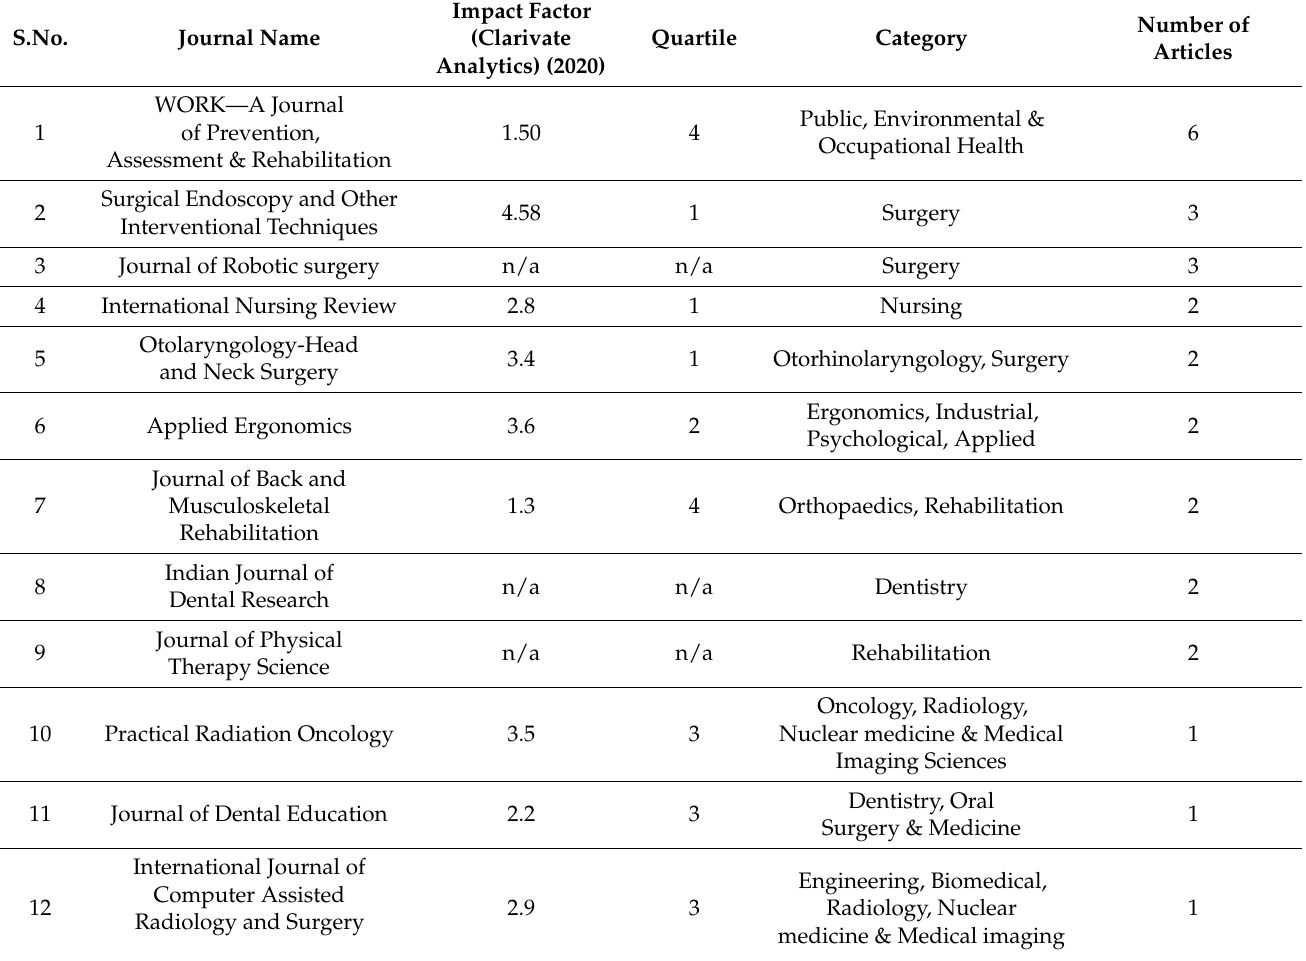
Table 2. Top Journals with their individual contribution to the 50 most-cited articles on WMSDs using RULA related to healthcare